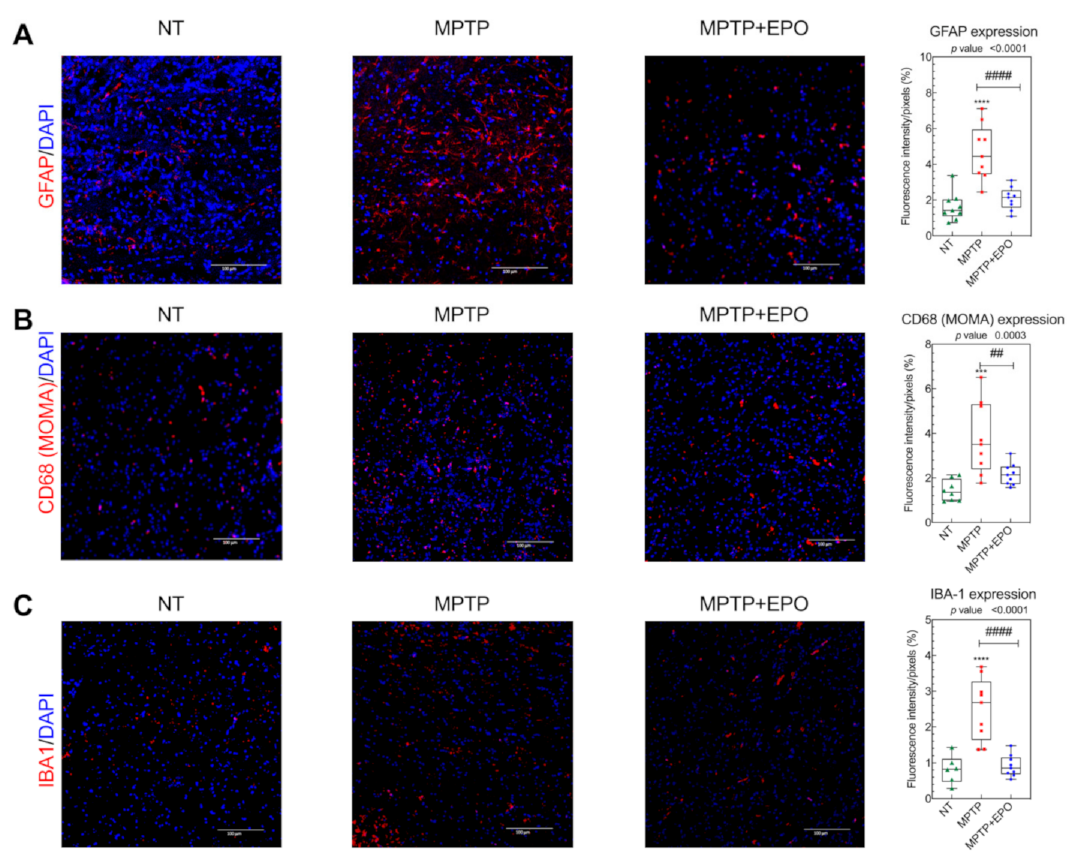
Figure 9. EPO counteracts the expression of neuroinflammation markers in brains of PD affected mice. anti-Glial Fibrillary Acidic Protein (GFAP) ( A ), mouse macrophage (MOMA) ( B ) and ionized calcium-binding adapter molecule 1 (IBA1) ( C ) ex- pression in the striatum was studied via immunofluorescence (see Section 2) in non-treated mice (NT), mice treated with MPTP (MPTP), and MPTP-treated mice after EPO injection (MPTP + EPO). Scale bar: 100 µ m. Data of immunofluorescence quantification are expressed as box and whisker plot of 3 animals for each condition ( n = 3 mice each condition; 3 slides per mouse; 2 images per slide) and results are represented as mean of optical density/pixels. (*** p < 0.001, **** p < 0.0001 vs. NT; ## p < 0.01 vs. MPTP; #### p < 0.0001 vs. MPTP). Fluorescence quantification was performed with the software Image-J